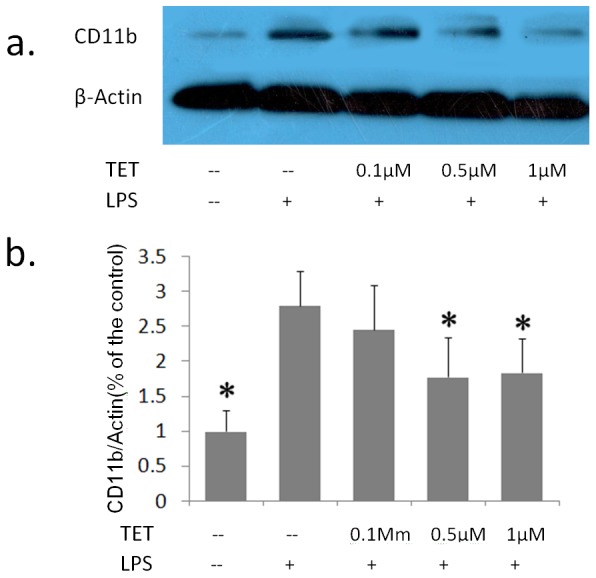
Effect of TET on CD 11b expression in BV2 cells.BV2 cells were treated with TET at working concentrations for 2 h. Then, LPS was added to each plate and incubated at 37°C for an additional 24 h.The cells were lysed for protein extraction. Fig. 4a: CD11b expression was measured by Western blotting analysis. Fig. 4b: The ratio of densitometry values of CD11b and β-actin was normalized to each respective control group. Results were the mean ± S.D. from three independent experiments performed in triplicate. *P<0.05 compared with the TET(−)LPS(+) group.